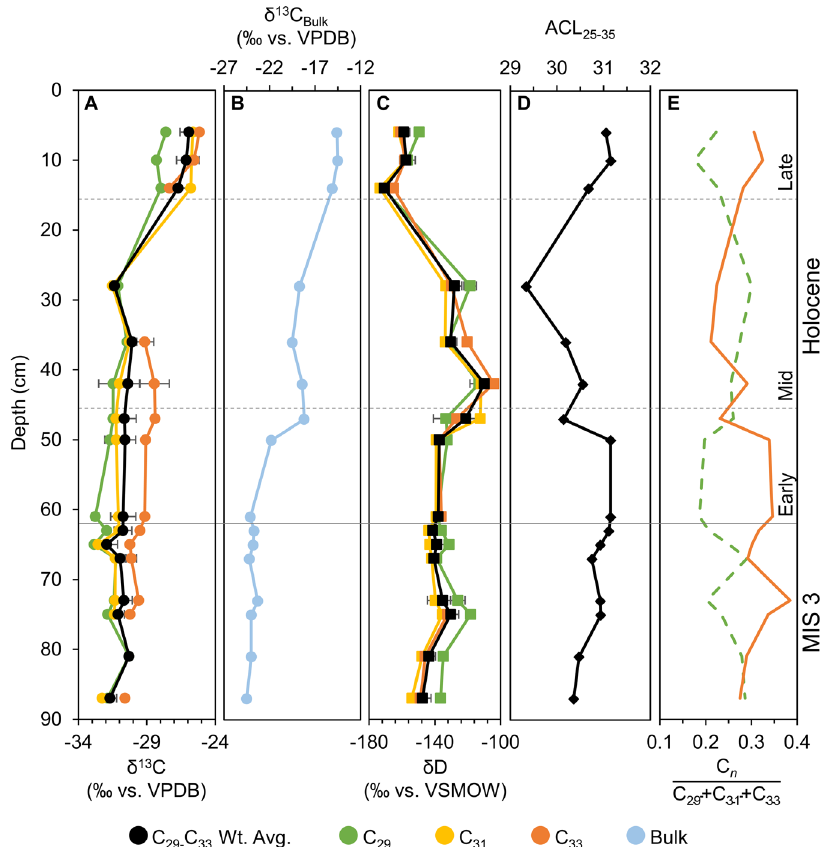
Fig. 3 Isotopic and biomarker signatures of Ha Makotoko archaeological sediments. A C 29 -C 33 n -alkane and weighted average δ 13 C values. B Mean bulk δ 13 C values for sedimentary organic matter 14 . C C n -alkane and weighted average δ D values. D Average chain length (ACL) of the C 29 -C 33 E Ratio values of C 33 (solid, orange) and C 29 (dashed, green) n -alkane abundances relative to dominant plant waxes (C 29 + C 31 + C 33 ). Higher values re fl ect relatively increased input of the respective